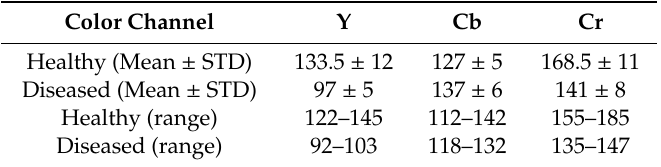
Figure 10 . Histograms of Y, Cb and Cr color features of the acquired images. ( a ) Healthy throat color component histograms, and ( b ) diseased throat color component histograms. Here, the x-axis shows the intensity value of each color channel while the y-axis shows the number of pixels. Table 1. Mean, standard deviation, and the range of the color intensity values of healthy and strep throats .